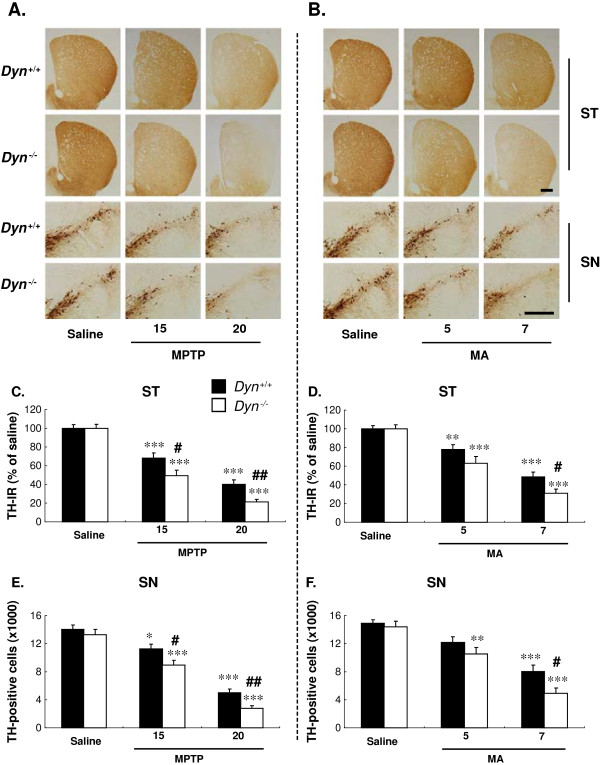
Prodynorphin gene deficiency exacerbates striatonigral dopaminergic neurotoxicity induced by MPTP or MA. Dyn+/+ and Dyn−/− received MPTP (15 or 20 mg/kg, i.p./day × 7) or MA (5 or 7 mg/kg, i.p./2 h × 4) as described in Figure 1. Tyrosine hydroxylase (TH)-immunoreactive neurons were stained and counted 7 days after the last treatment with MPTP or MA by immunocytochemistry with an antibody against TH. Immunostaining of nigrostriatal TH-positive neurons treated with saline, MPTP (A), or MA (B) in Dyn+/+ and Dyn−/−. Immunostaining of striatal TH-positive fibers was quantified using ImageJ (C, D). Numbers of TH-positive neurons in the SN pars compacta were counted by stereological analyses (E, F). For more details, refer to ‘Methods’. ST = striatum. SN = substantia nigra. Each value is mean ± S.E.M of eight mice. *P <0.05, **P < 0.01, ***P < 0.001 vs. respective saline group, #P <0.05, ##P <0.01 vs. MPTP- or MA-treated Dyn+/+ (two-way ANOVA followed by post-hoc Tukey HSD test or pairwise comparison with paired t-test). Scale bar = 400 μm.